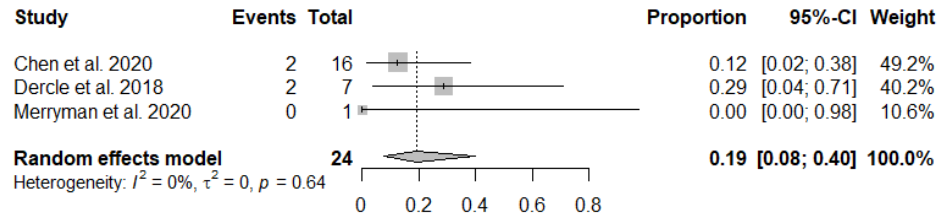
Figure 5. Forest plots show the pooled incidence of pseudoprogression among patients with an indeterminate response.